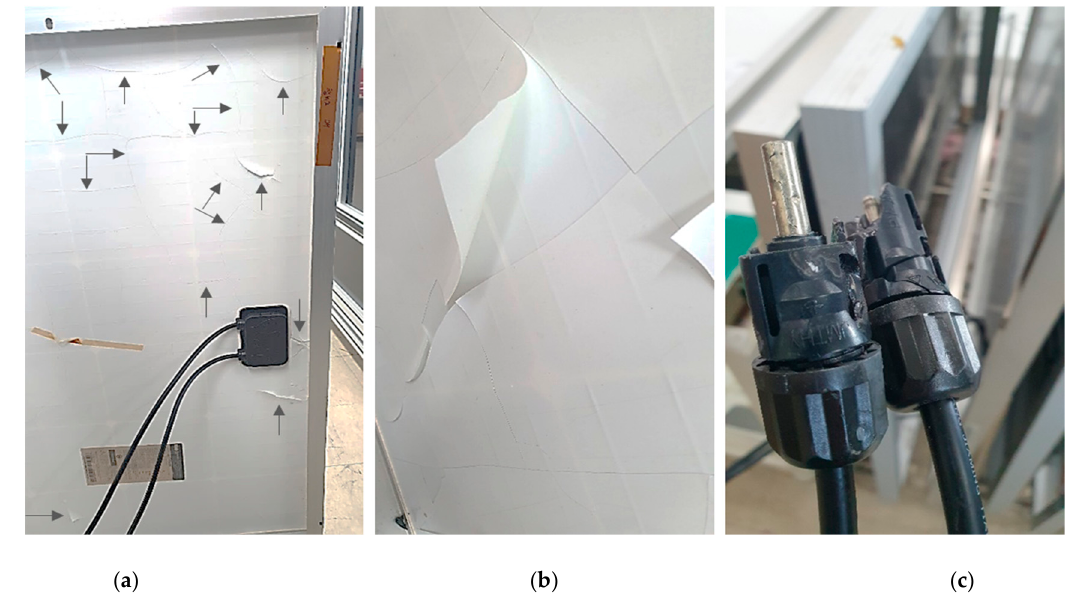
Figure 5. Physical damage observed for the tested module after DH7000: ( a ) cracks of backsheet, ( b ) cracks and delamination of backsheet, and ( c ) broken cable connectors.